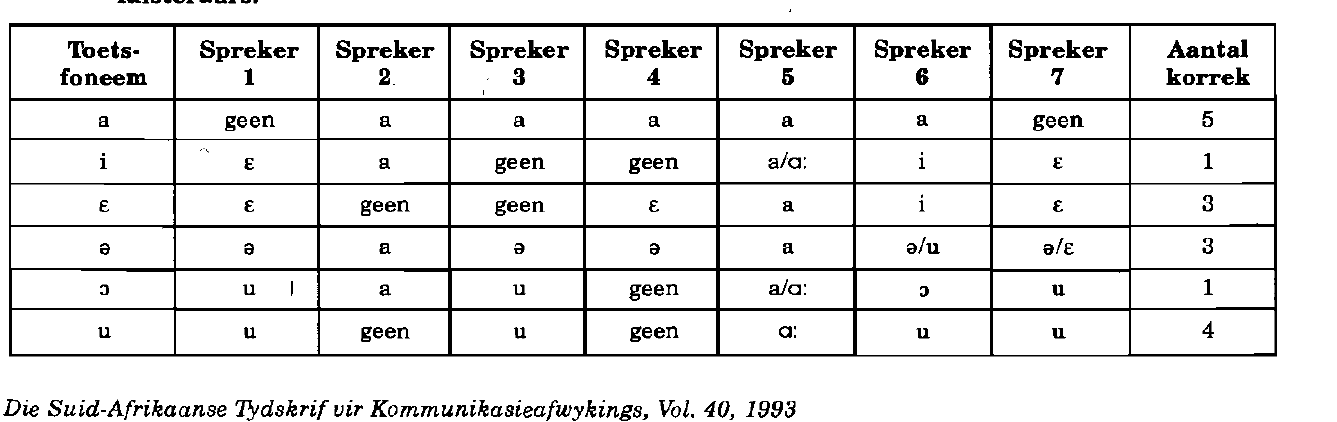
Tabel 11. Konstanthede identifiseerbaar in elke gehoorgestremde spreker se vokaalproduksie deur twee